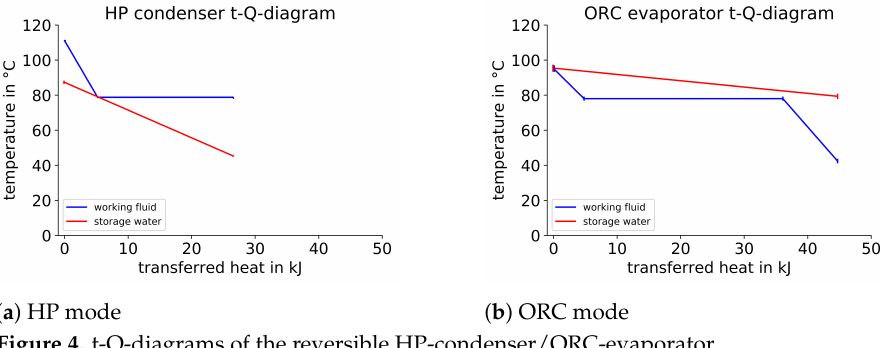
Figure 4. t-Q-diagrams of the reversible